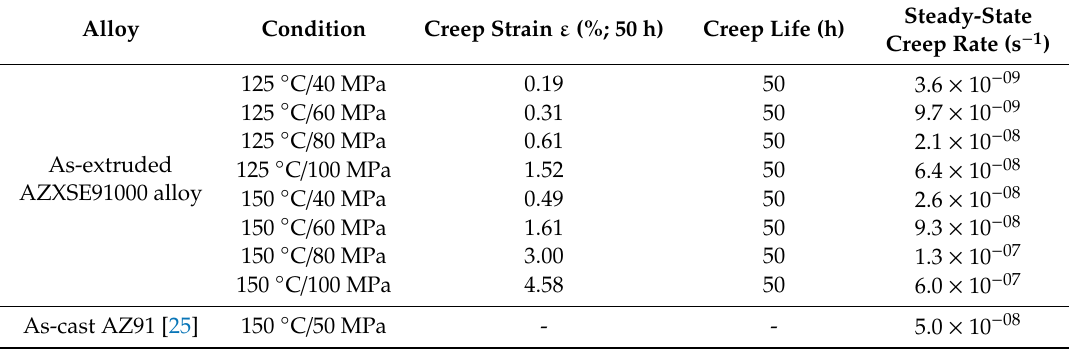
Table 3. The creep experimental results of the as-extruded AZXSE91000 alloy at 125–150 ◦ C / 40–100 MPa and steady creep rate of the as-cast AZ91 alloy.